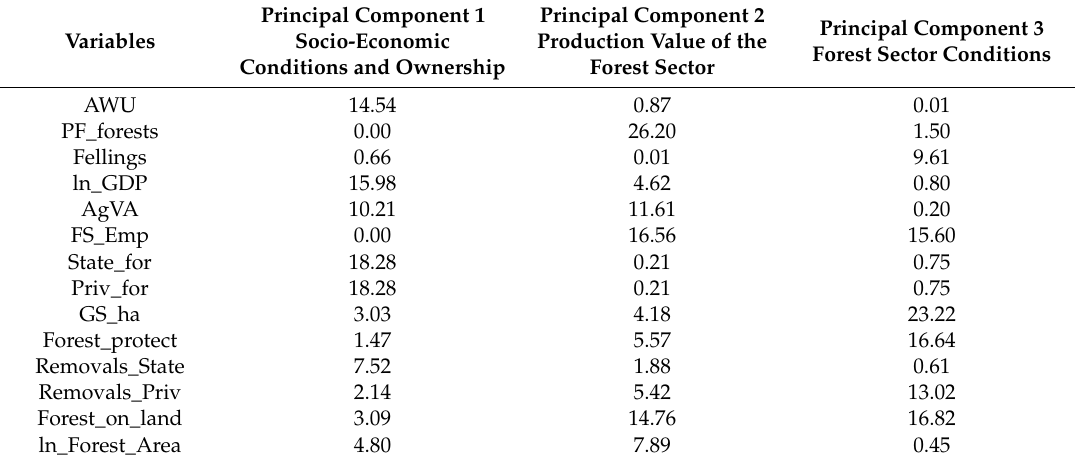
Figure 3. Countries score for the first and third PCs. Table 2. Contribution of each variable to the first three principal components in % (own elaboration).